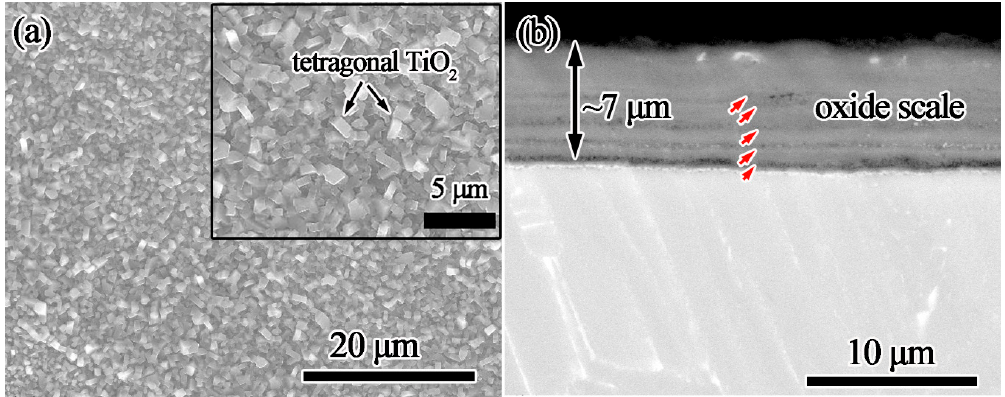
Figure 4. Surface ( a ) and cross-sectional ( b ) morphology of the bare Ti60 alloy after oxidation at 800 °C for 100 h.